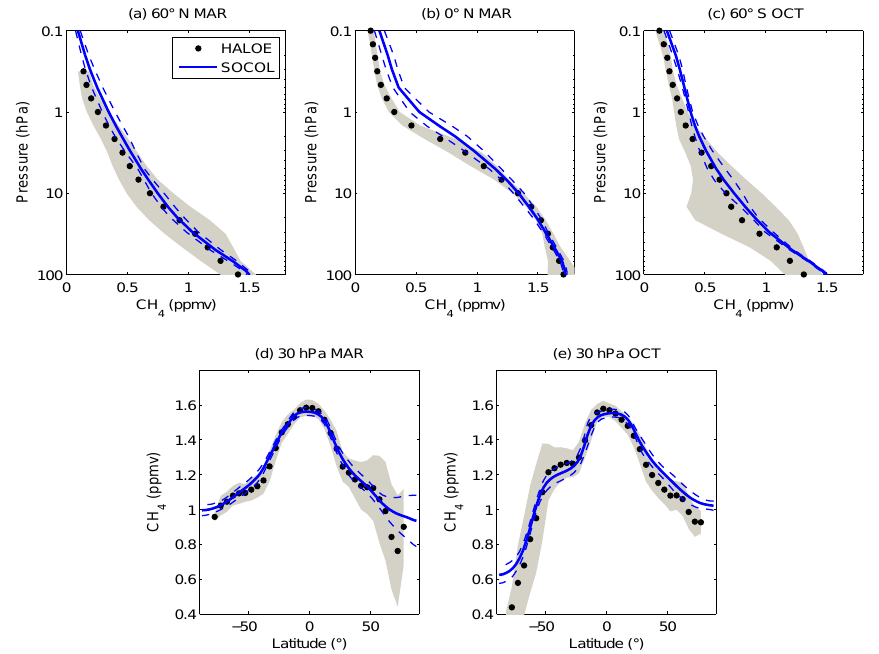
Figure 3. Modelled methane concentrations from the SOCOL v.3 RCP 6.0 simulation compared with HALOE observations (climatological means for 1991–2002) for (a) 60 ◦ N, March; (b) the Equator, March; (c) 60 ◦ S, October; (d) 30hPa, March; (e) 30hPa, October. The grey shaded areas represent 1 standard deviation either side of observations and the dashed blue lines represent 1 standard deviation either side of model